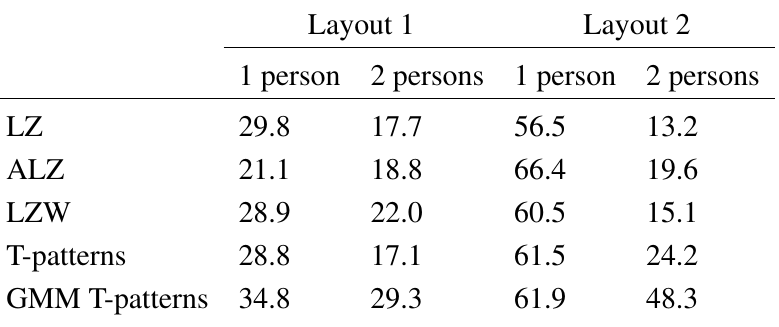
Table 1. Percentage correct predictions at the 20% confidence level. randomness, the prediction upper-bound is